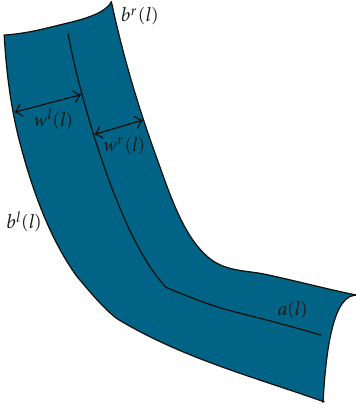
Figure 2: Definition of curvilinear region for a continuous case. b l ( l ) and b r ( l ) are the left and right borders, respectively; a ( l ) is the medial axis; and w l ( l ) and w r ( l ) are the left and right widths,